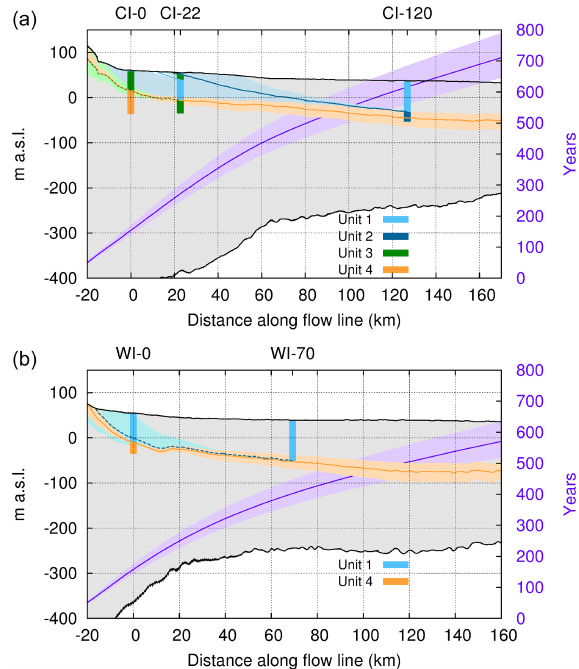
Figure 5. Flow lines initiated along trajectories from the grounding line towards the ice-shelf edge for (a) Cabinet Inlet and (b) Whirl- wind Inlet. The timescale is from the beginning of the trajectory. The borehole ice units correspond to those described in Ashmore et al. (2017) and are described in the text. The shaded boundaries represent the uncertainty estimates as described in the